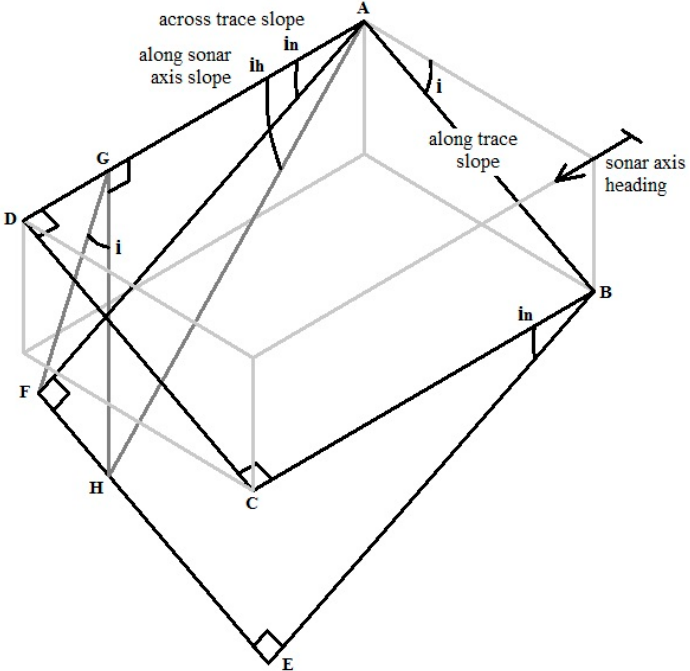
Figure 8. The effect of an across-trace seabed slope on the area of seabed ensonified by the sonar pulse when the along-trace seabed slope is not zero. The grey net represents a cuboid of horizontal and vertical rectangular faces. The line AB represents the sonar trace on the seabed sloping along-trace at an angle i . The face ABCD has zero across-trace slope. This rotates about the line AB onto the face ABEF, which has an across-trace slope i h From Figure 8: the line FH is parallel to the lines AB and CD; the triangle FGH is situated in a vertical plane; and the line GH also is vertical. It then follows that: